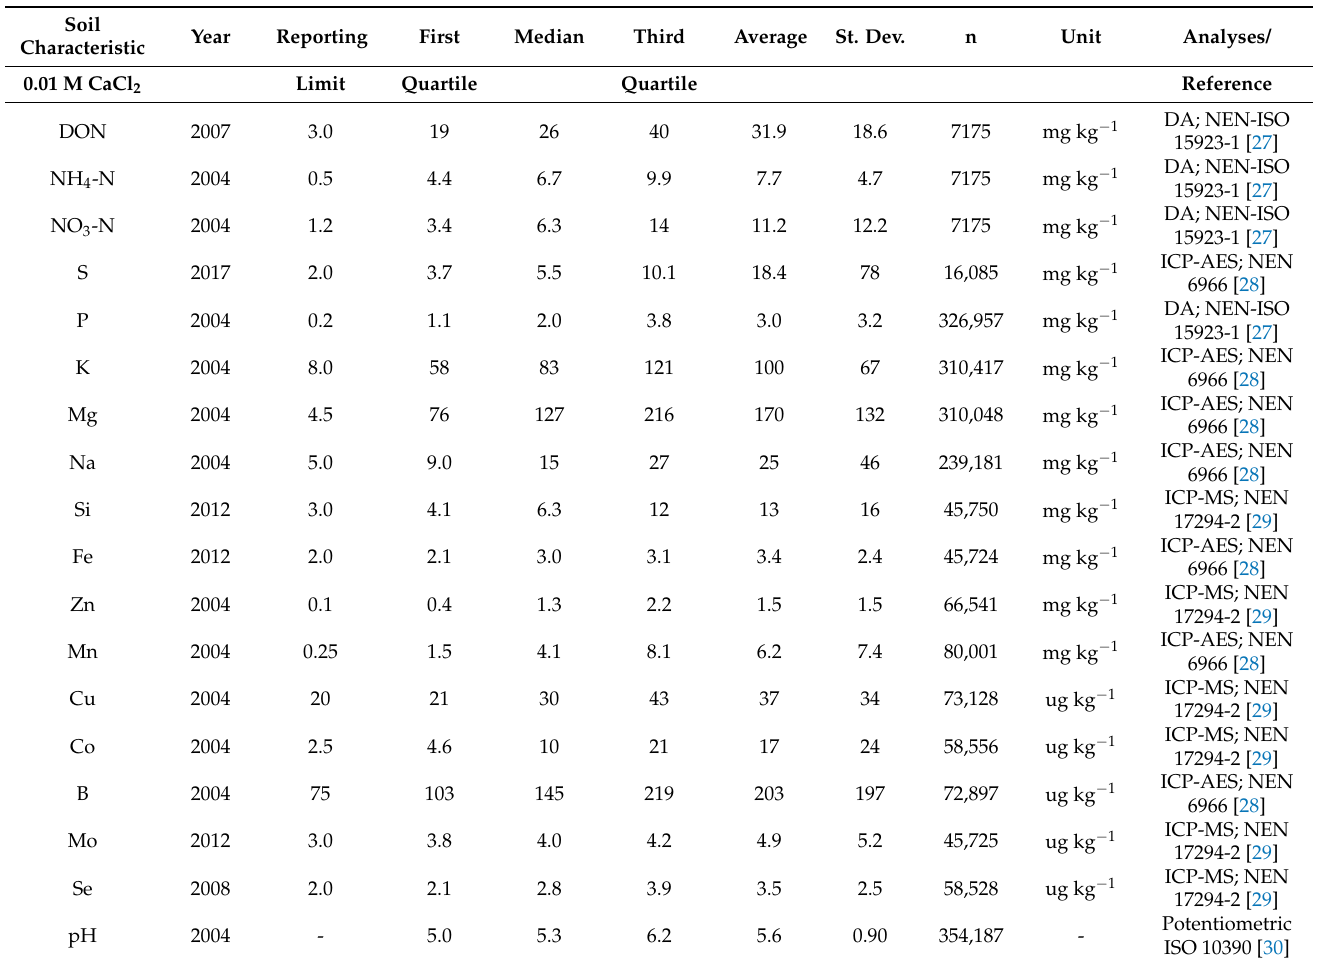
Table 1. Descriptive statistics of the 0.01 M CaCl 2 extractions (1:10 soil to solution ratio; w / v ). Year = year of introduction for routine soil testing. DON = dissolved organic nitrogen. All data are from period 2010–2014, except for S (routinely introduced into testing in 2017), and pH (2005–2009, routinely measured by NIRS in the last decade) (Step